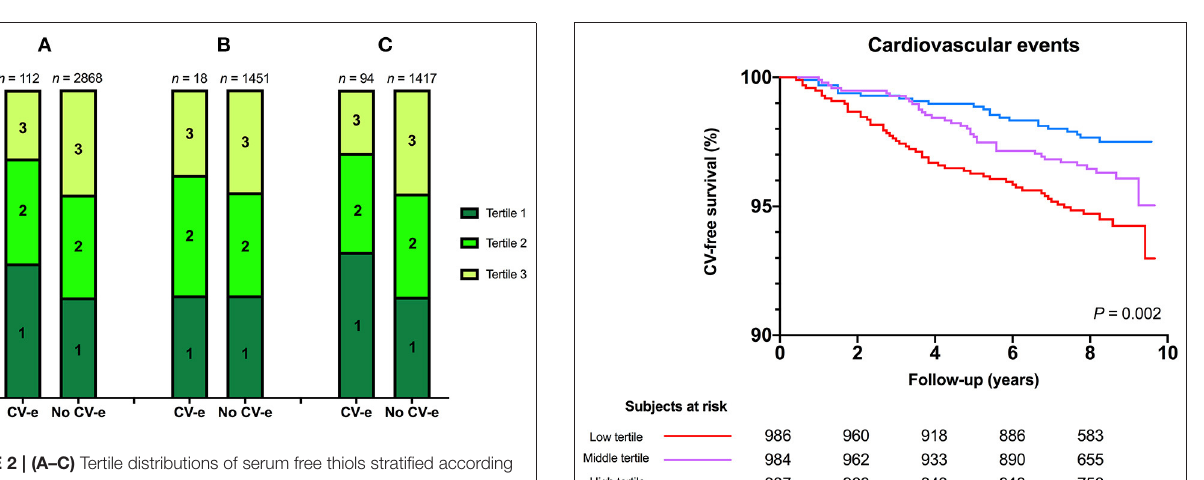
patients of younger age and lower BMI having significantly higher serum free thiol levels ( β = − 0.312 and β = − 0.181, respectively, both P < 0.001, Supplementary Figures 3A,B